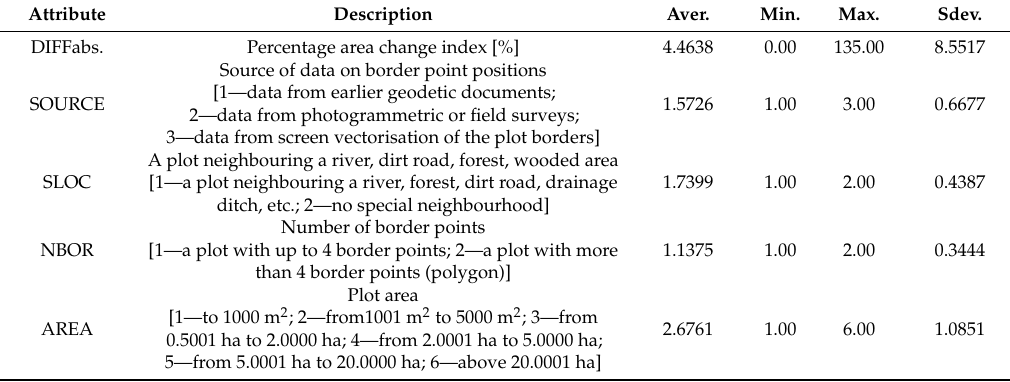
Table 2. Basic statistical data of the model, together with attribute